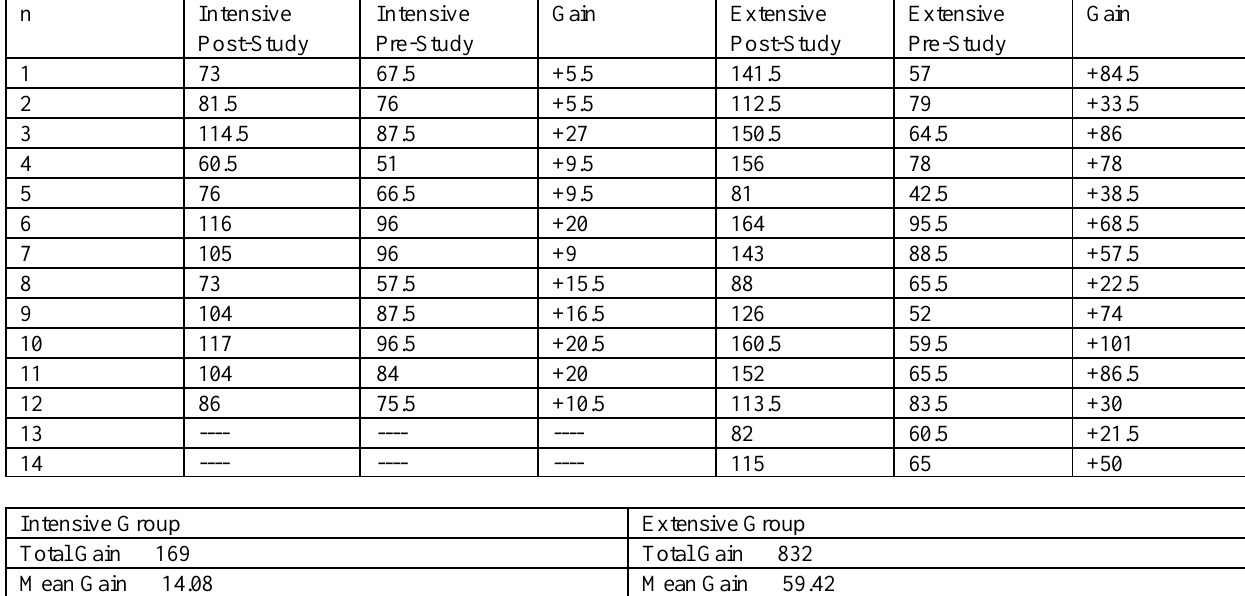
Table 4.3 Reading Speed: Analysis of Gains Texts 1 and 2 Combined n